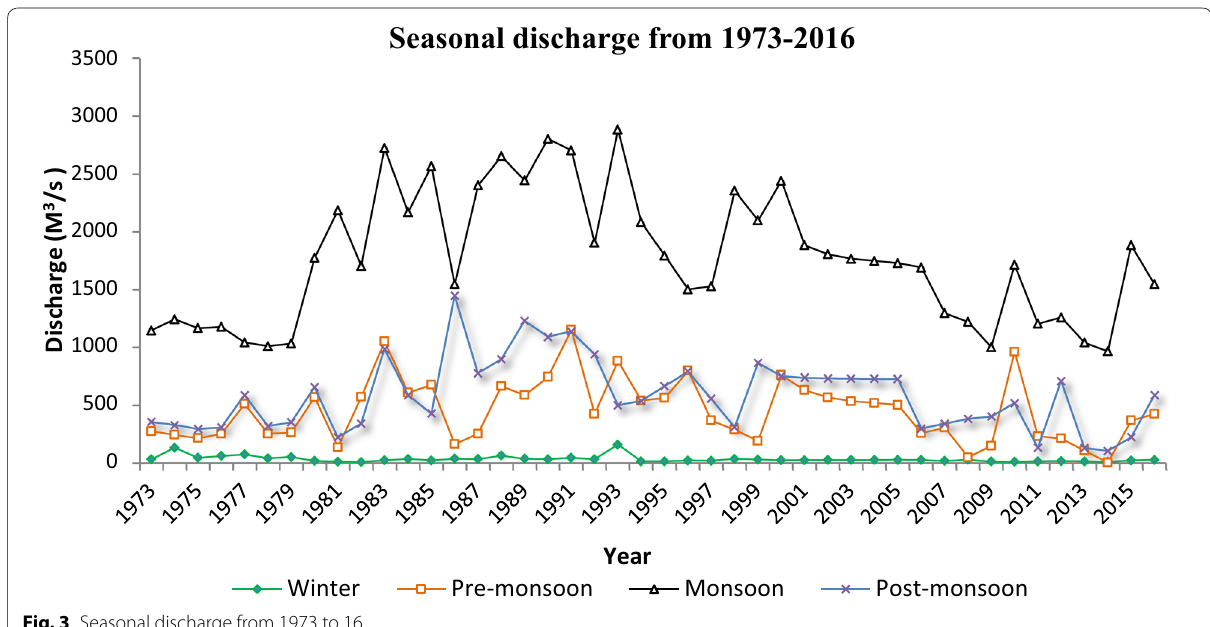
Fig. 3 Seasonal discharge from 1973 to